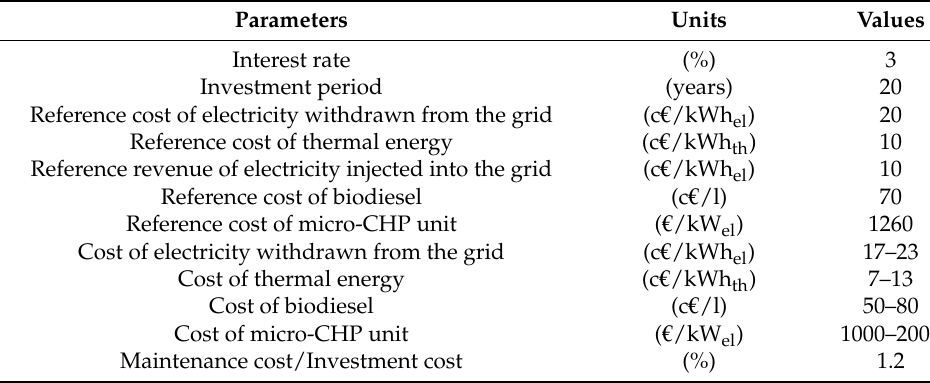
Table 3. Main assumptions for the economic